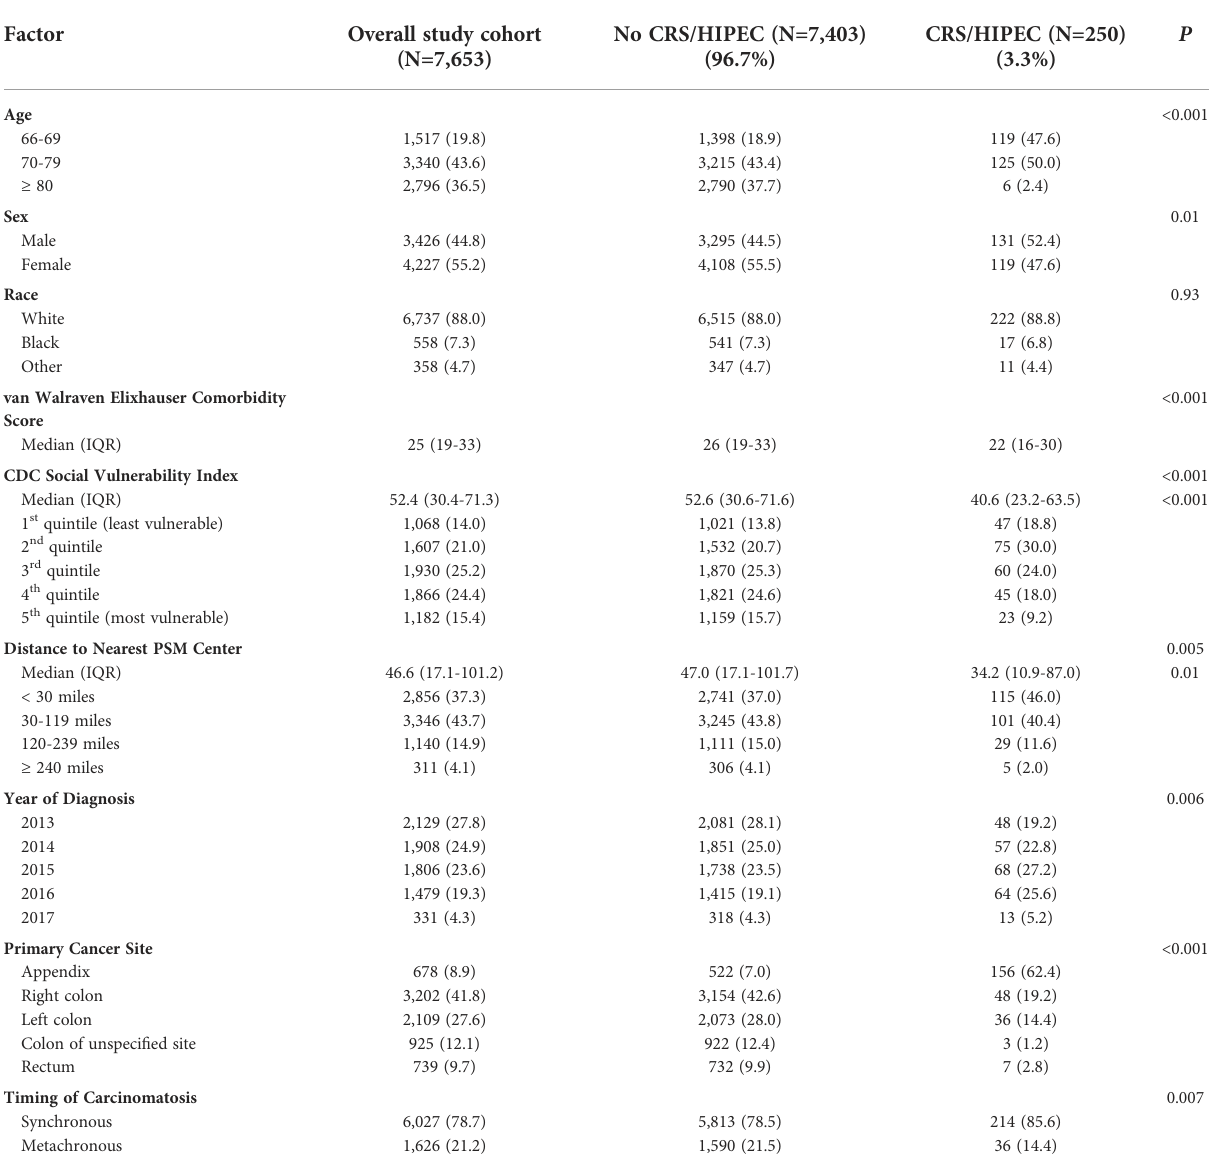
TABLE 1 Bivariate analysis of factors associated with